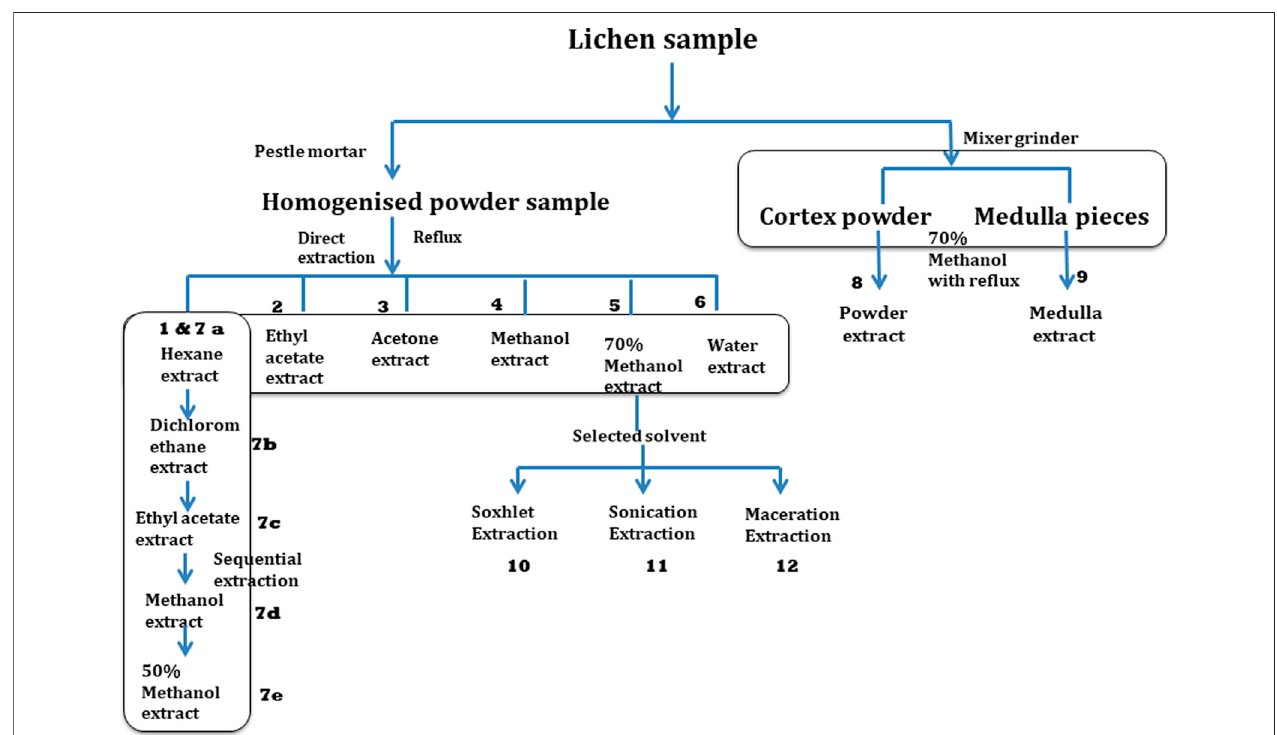
FIGURE 2 | Experimental design for the preparation of different